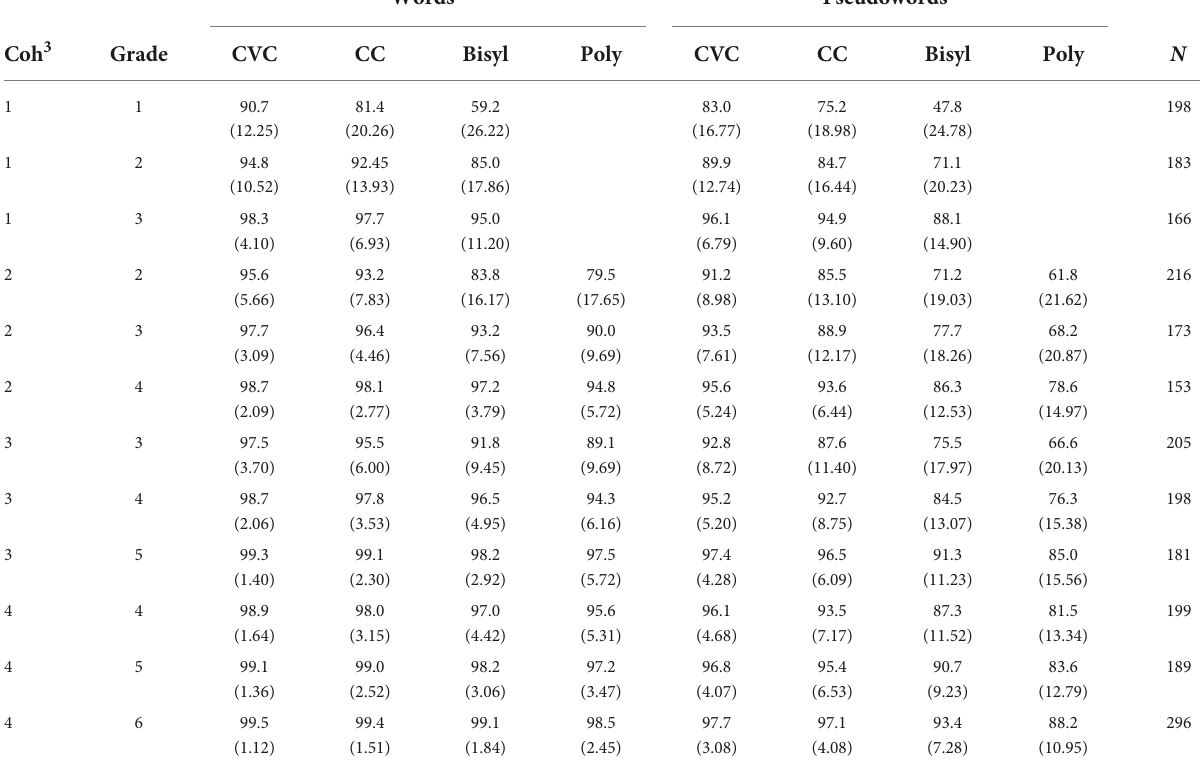
TABLE 3 Means and standard deviations (within parentheses) of word decoding accuracy for different types of words and pseudowords in four cohorts of students at the end of three school years in each